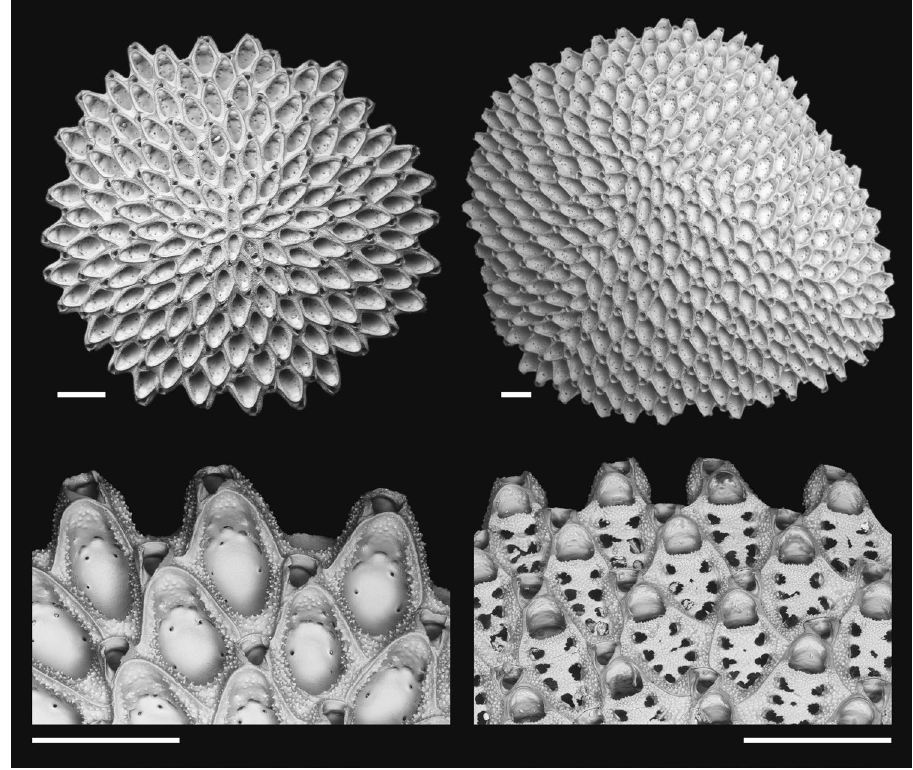
Figure 1. Examples of cupuladriid bryozoans and their morphology. Top, whole colonies of Cupuladria biporosa showing typical disc-like colony form with a sexually-produced colony (left) and a clonal colony (right). Bottom, marginal autozooids and vibracula of C. biporosa (left) and Discoporella bocasdeltoroensis (right). Scale bar = 500 µ m. Images courtesy of Paul. D.